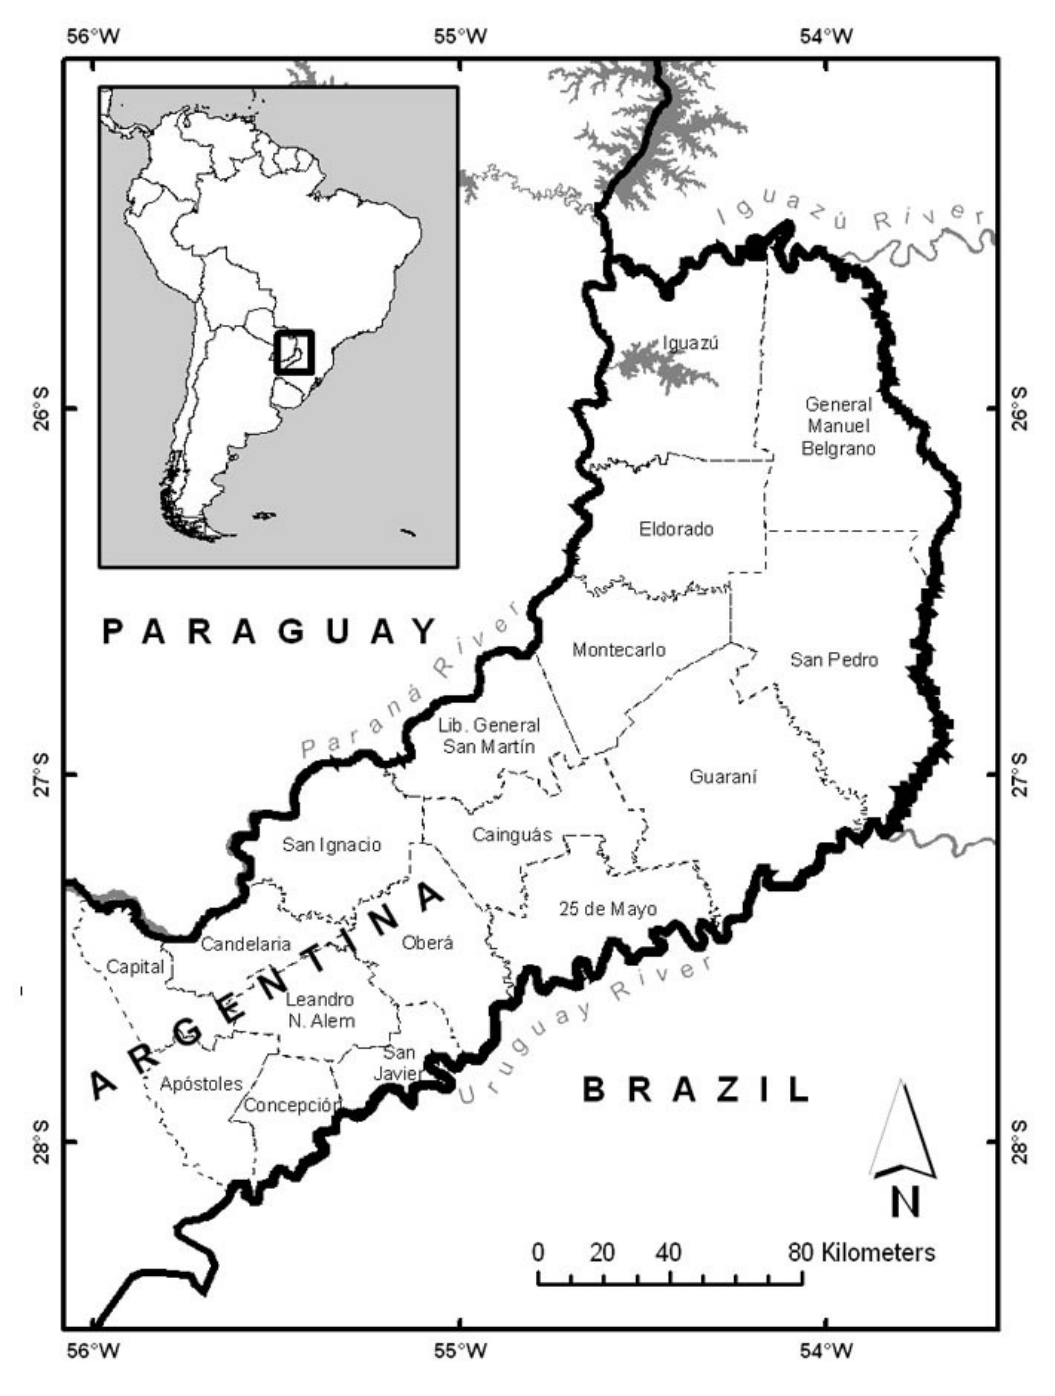
Fig. 1. Location of the province of Misiones, Argentina, in South America (inset), and the distribution of the 17 departments within the